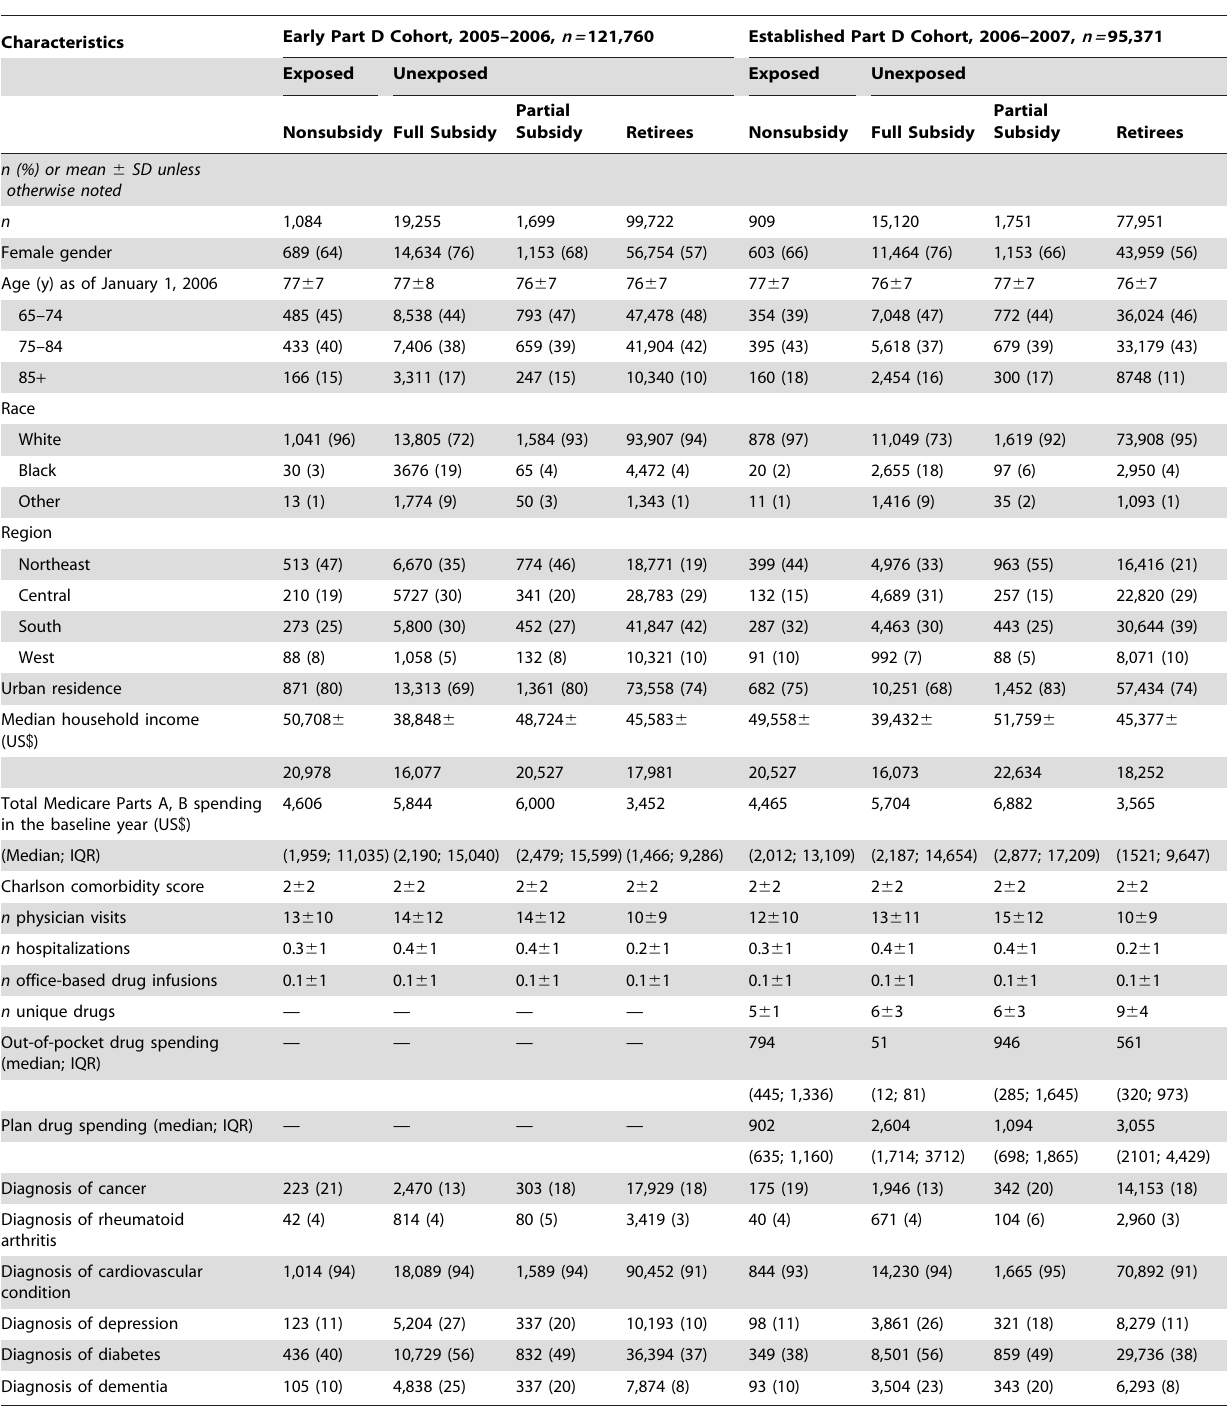
Table 1. Baseline characteristics of 217,131 beneficiaries who reached the coverage gap spending threshold, by exposure status and benefit